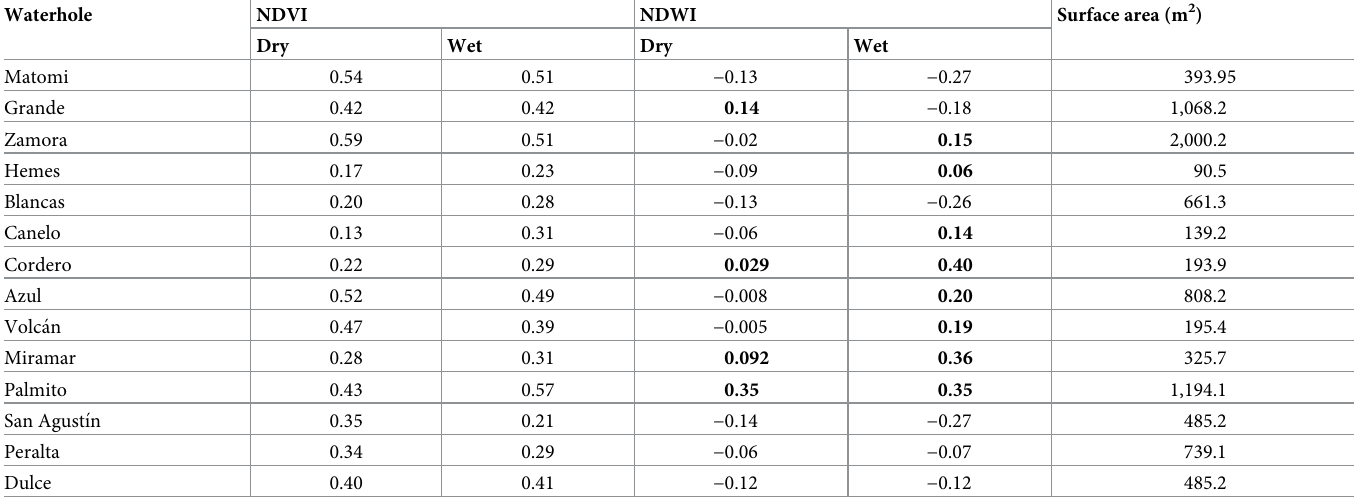
Table 1. Seasonal NDVI and NDWI; the maximum value of the pixel where the waterhole was detected. Bold type indicates waterholes detected with NDWI. Seasons were wet (November to February) and dry (May to July). The sizes of the waterholes were estimated in the wet season, area is in m 2 . Waterhole